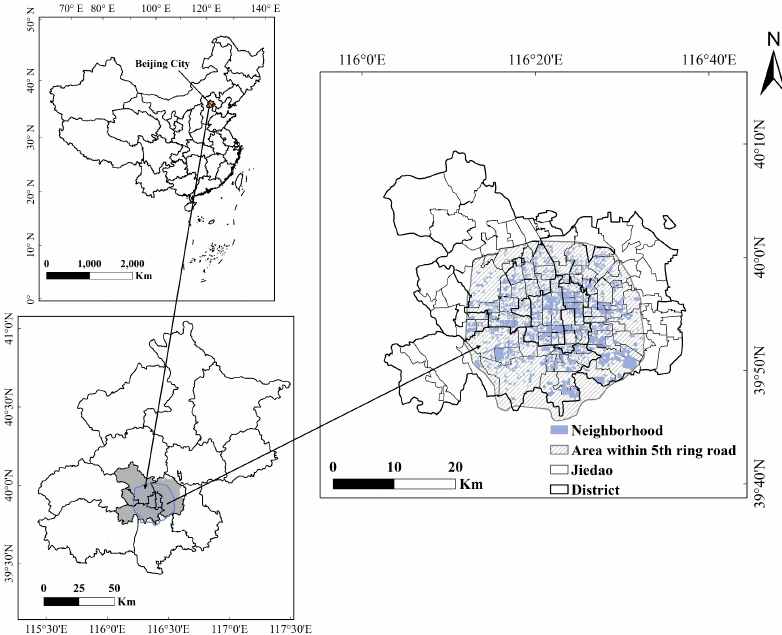
Figure 1. Study area: Neighborhoods within fifth ring road in Beijing, China.